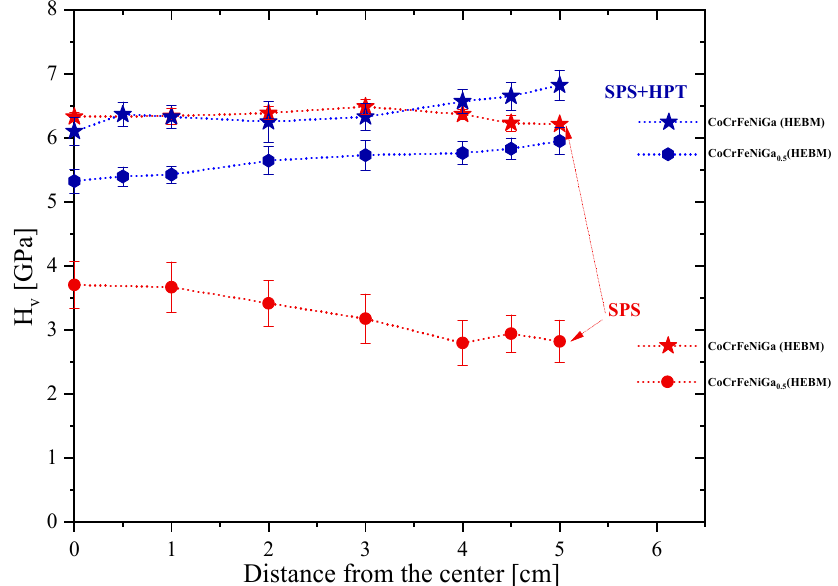
Figure 11. Dependence of the Vickers hardness on the radial distance from the center for SPS- consolidated (red), and subsequently HPT-deformed (dark blue) CoCrFeNiGa x (x = 0.5, 1.0) samples from HEBM powder mixtures.